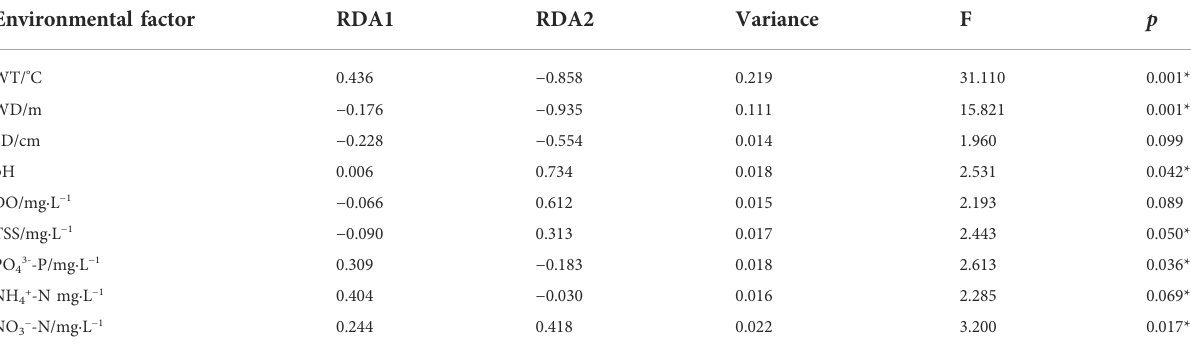
TABLE 5 Results of RDA of phytoplankton and explanatory factors in Lake Wuchang. Environmental factor